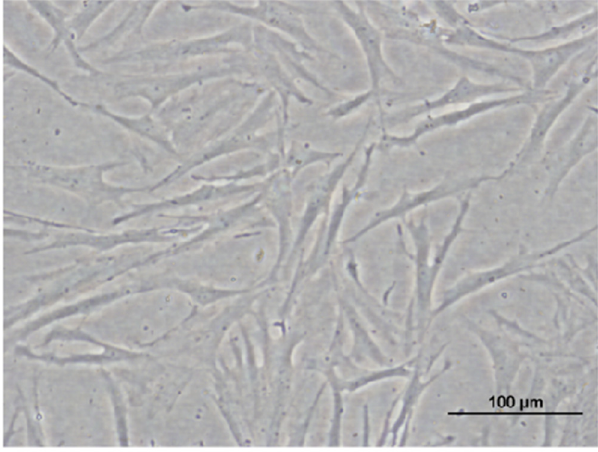
Figure 1. Cm cells in culture resemble fibroblast morphology.